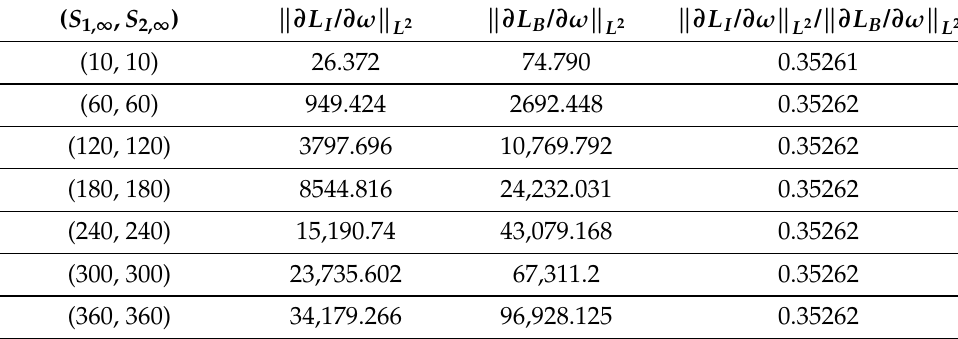
Table 4. Gradient value for different domains with scaled